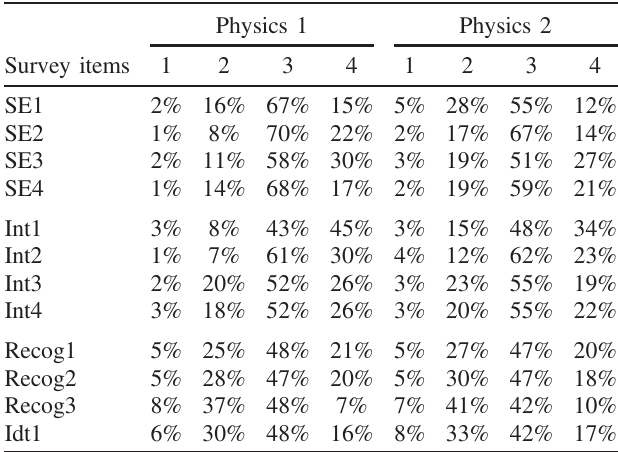
TABLE XII. Percentages of male students who selected each choice from a 4-point Likert scale for each survey item in physics 1 and physics 2. The self-efficacy and interest items have the response scale: 1 ¼ NO ! , 2 ¼ no, 3 ¼ yes, and 4 ¼ YES ! , while the perceived recognition and identity items have the response scale: 1 ¼ strongly disagree, 2 ¼ disagree, 3 ¼ agree, and 4 ¼ strongly